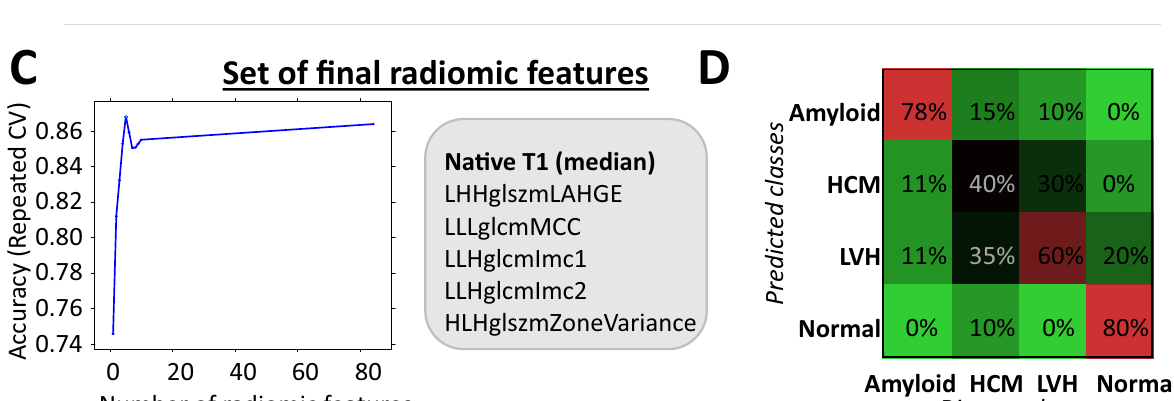
Figure 4. ( A ) Correlation plot of the stable T1 radiomic features (n = 628) and resulting clustering in groups of highly correlated features based on spearman’s rho coefficient and resulting correlation plot after stepwise exclusion of highly correlated radiomic features (n = 84) which were subsequently tested for classification of cardiac phenotype. ( B ) The population of Arm 2 was split in a training (67%) and validation (33%) dataset for model training and validation, respectively. The 84 stable and non-highly correlated T1 radiomic features were entered in multinomial models trained with fivefold cross-validation repeated 3 times, which were then tested in validation dataset. ( C ) A set of the most important radiomic features that maximized model’s accuracy were finally selected. ( D ) Confusion matrix for predicted vs observed classes with the use of the final radiomic model in the testing dataset. AUC area under curve, CV coefficient of variation, HCM hypertrophic cardiomyopathy, LVH left ventricular